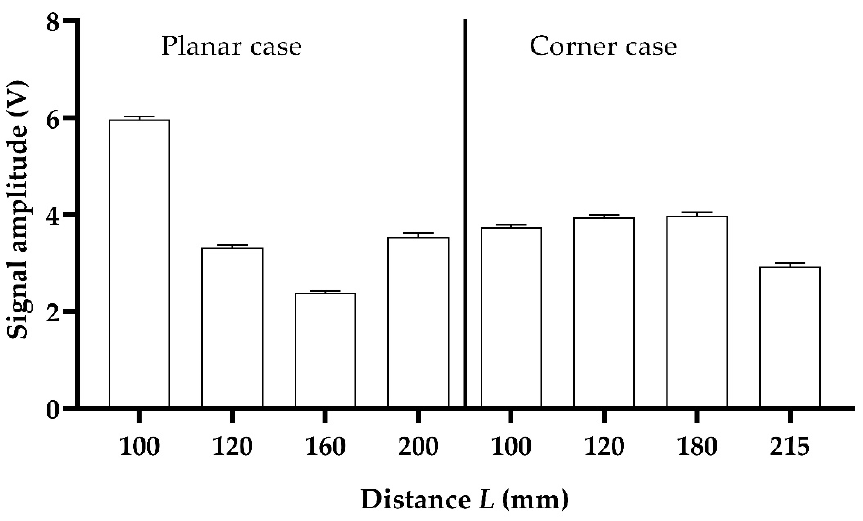
Figure 3. Statistical evaluation of the signal amplitudes from the acquired experimental data.